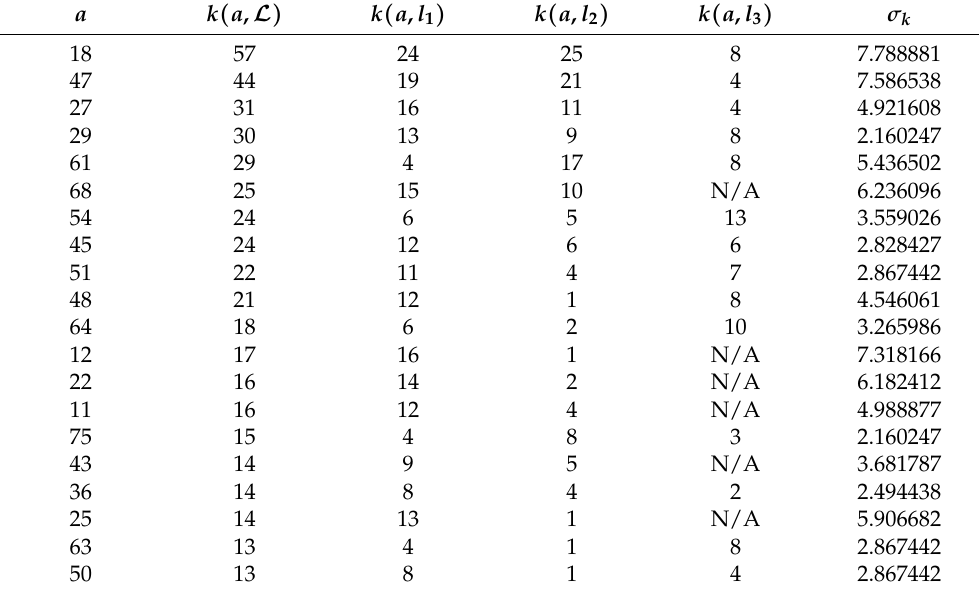
Table 2. Degree and degree deviation computed on the 20 highest-degree actors on the whole Montagna multiplex network and on its single